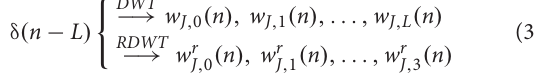
errors in the reconstructed signal. One of the shortcomings